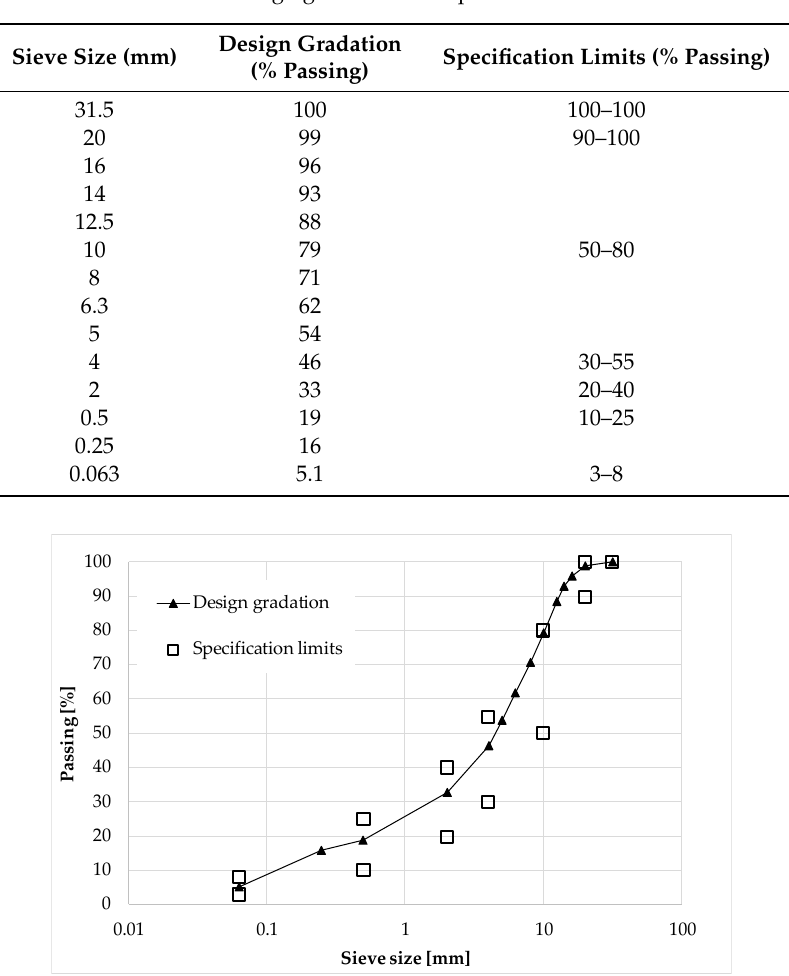
Figure 1. Design gradation.